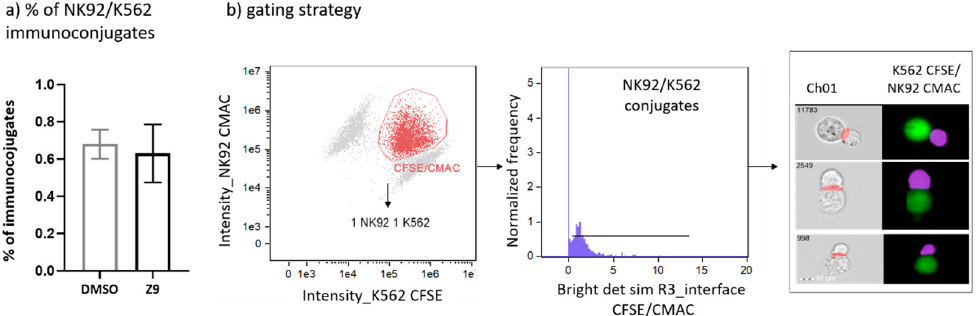
Figure 7. Determination of the proportion of NK-92/K-562 immunoconjugates. Comparison of NK-92/K-562 immunoconjugate frequency between DMSO and Z9-treated samples ( a ). Gating strategy used for determination of the proportion of immunoconjugates formed between NK-92 and K-562 cells ( b ). The figures are representative of two independent experiments.